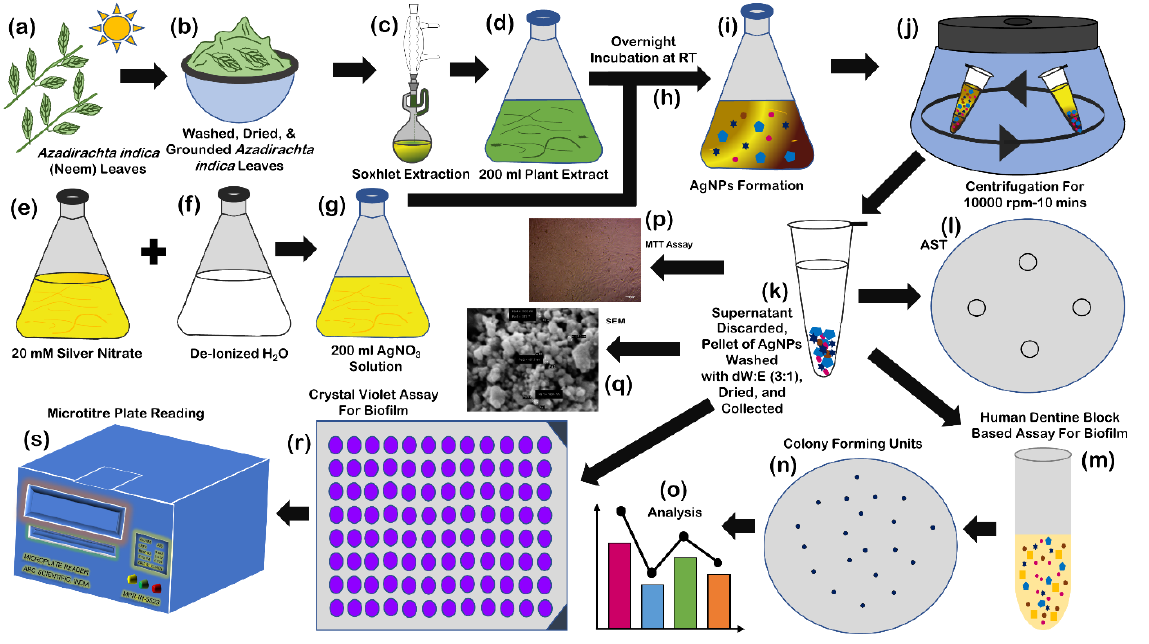
Figure 6. Synthesis of silver nanoparticles: collection of Azadirachta indica (neem) leaves ( a ); washing, drying, and grounding of leaves ( b ); Soxhlet extraction ( c ); collection of extract ( d ); preparation of 200 mL 20 mM silver nitrate solution ( e ); 200 mL deionized water ( f ); mixing of silver nitrate solution and deionized water (at the time of mixing) ( g ); incubation at room temperature for 12–18 h ( h ); change of color of mixture after 12–18 h ( i ); centrifugation at 1000 rpm for 10 min ( j ); collection of pellet after discarding the supernatant, washing of pallet with solution of deionized water and ethanol (3:1) for three times, drying, and collection of nanoparticles ( k ); human dentine-block-based biofilm assay ( l – o ); cytotoxicity assay ( p ); SEM analysis ( q ); and crystal violet-based biofilm assay ( r , s